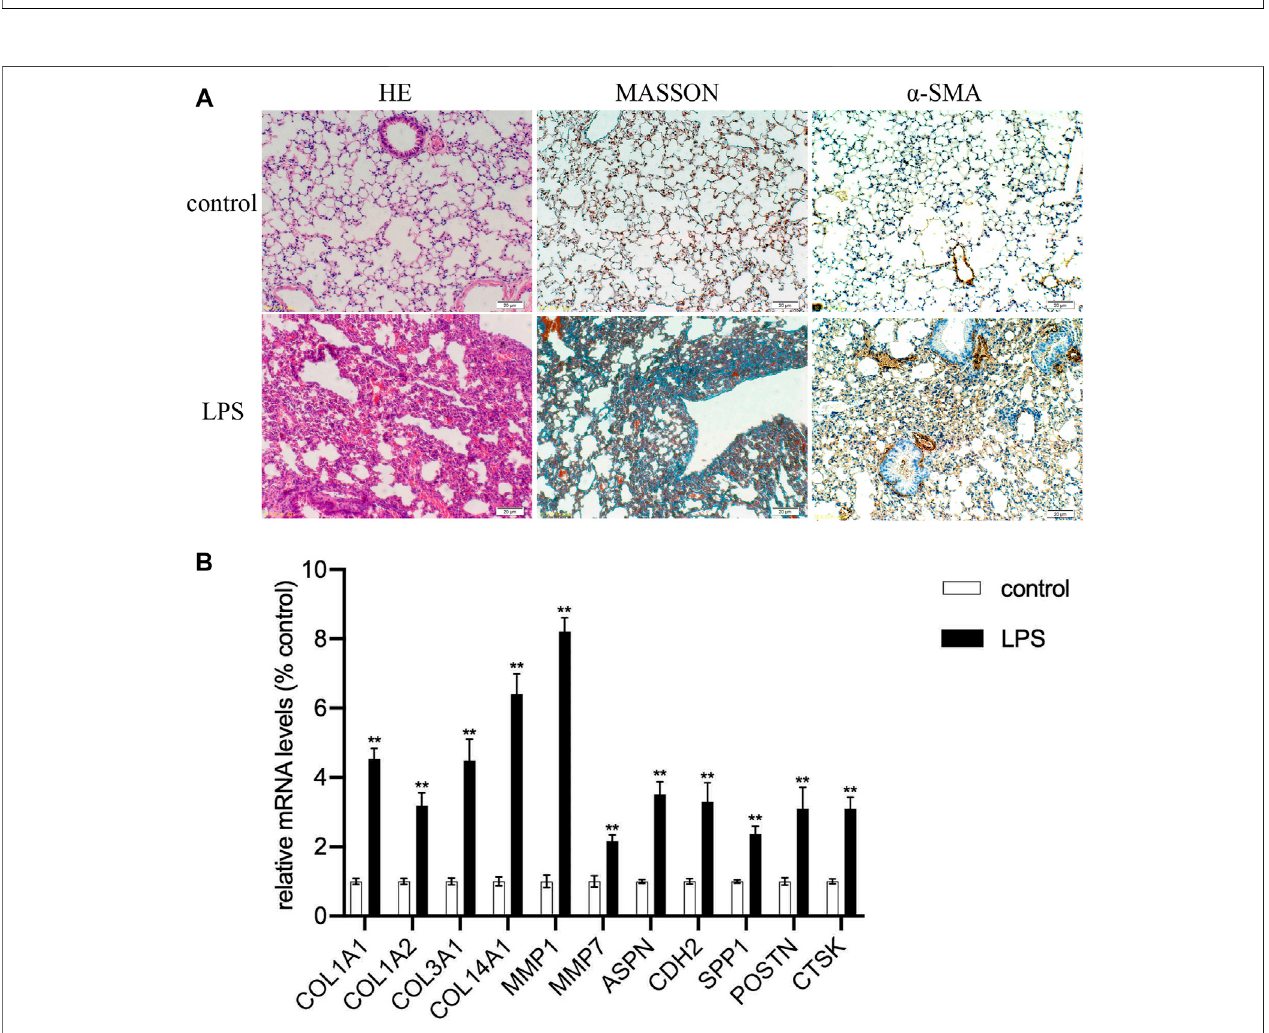
FIGURE7| Expressionvalidationofhubgenes. (A) Theseverityofpulmonary fi brosiswasdetermined byhematoxylin-eosin (HE)staining,collagendepositionwas assessed byMasson ’ s trichrome staining, and α -SMAexpression inthe lung tissue wasdetectedbyimmunohistochemistry (magni fi cation, × 200). (B) Expressionlevels of COL1A1, COL1A2, COL3A1, COL14A1, MMP1, MMP7, ASPN, CDH2, SPP1, POSRN, CTSK mRNAs in lung tissue samples (** p < 0.01).